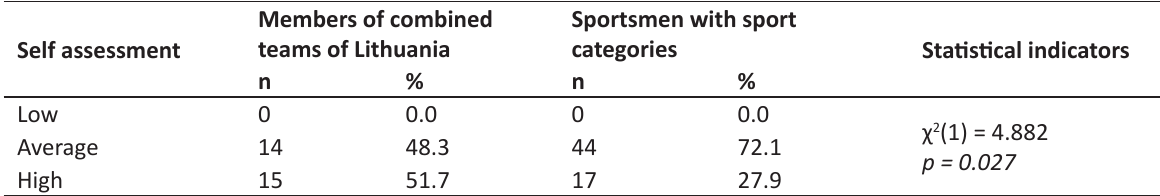
Table 5. self-assessment of different sportsmanship athletes